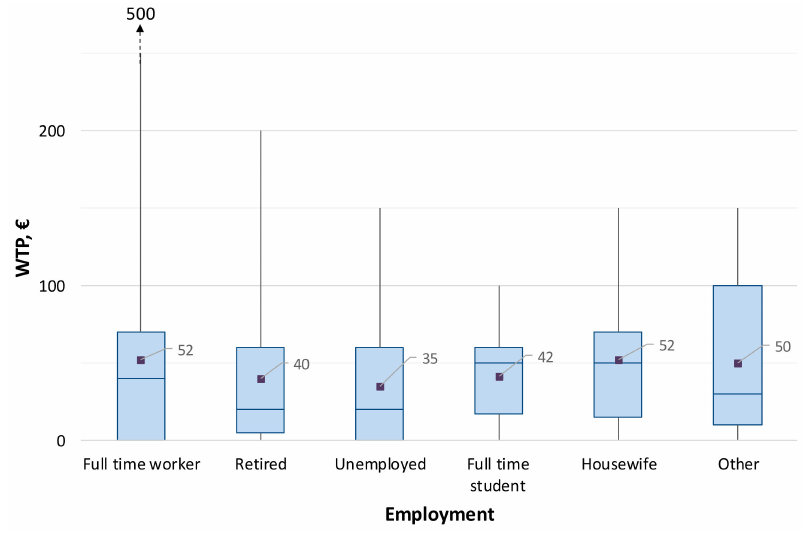
Figure 11. Distribution of WTP with respect to professional